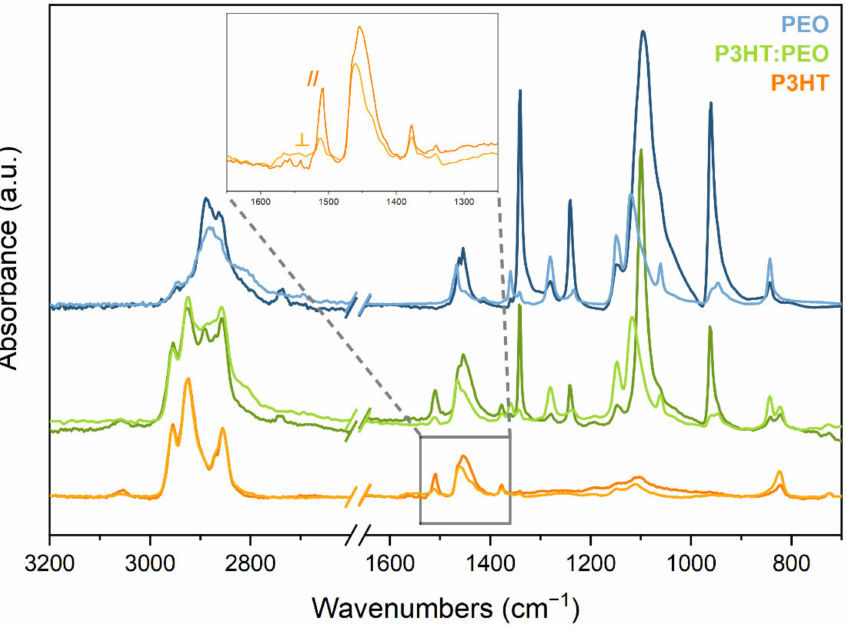
Figure 4. Infrared spectra of PEO ( blue lines ), P3HT:PEO ( green lines ) and P3HT ( orange lines ) macroscopically aligned nanofibres in linearly polarised light. Lighter coloured lines refer to spectra recorded with light polarised perpendicular to the nanofibre axis direction, while darker lines refer to spectra recorded with light polarised parallel to the nanofibres’ axis